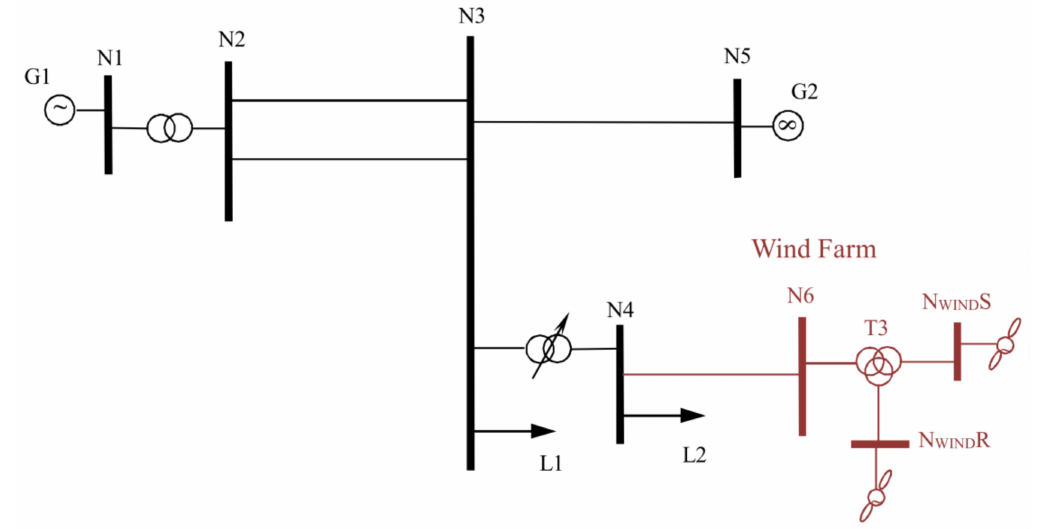
Figure 6. Single line diagram of the power